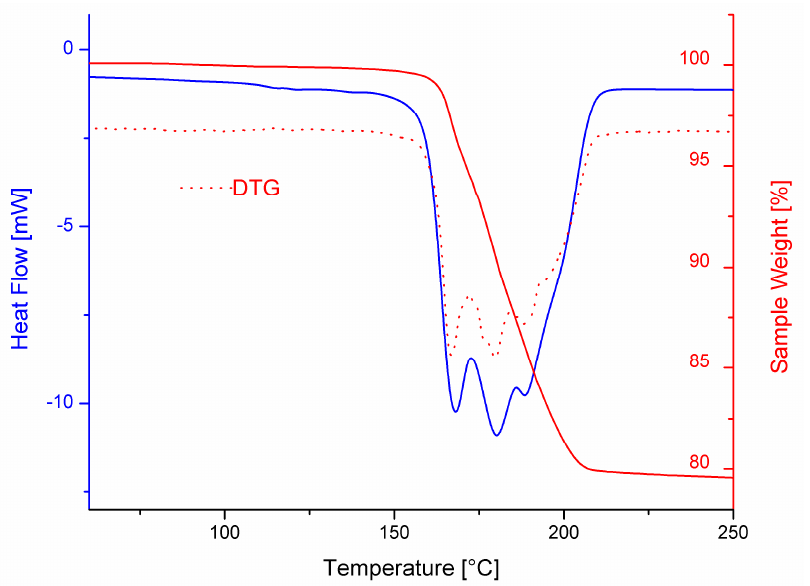
Figure 4. The DSC (blue), thermal (red), and differential thermal (red dotted) curves for the amorphous sample.